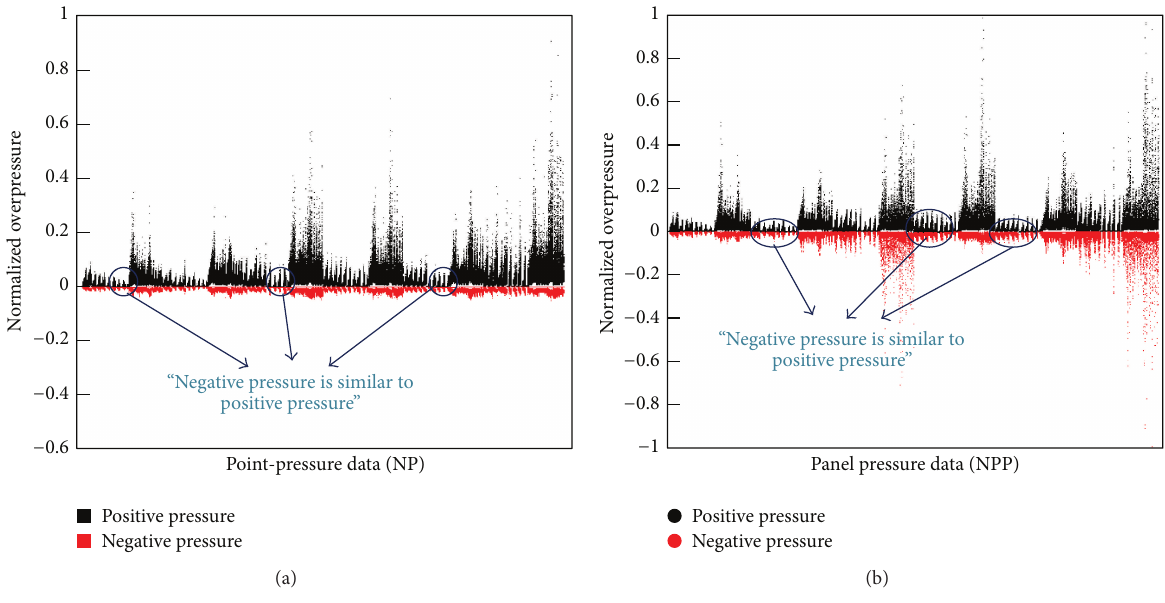
Figure 5: The comparison between positive and negative overpressure according to data types: (a) point pressure data type and (b) panel pressure data